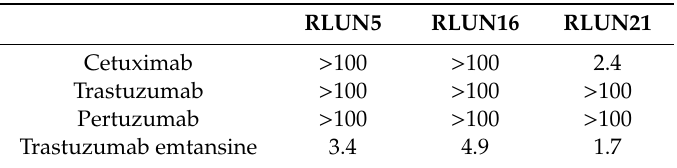
Table 1. Half-maximal inhibitory concentration (IC 50 ) values of trastuzumab, pertuzumab, cetuximab, and trastuzumab emtansine against each